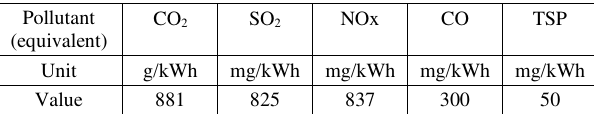
Table 6. Calculated emission factors for electricity needed for charging EV at low voltage in Polish conditions Pollutant (equivalent)